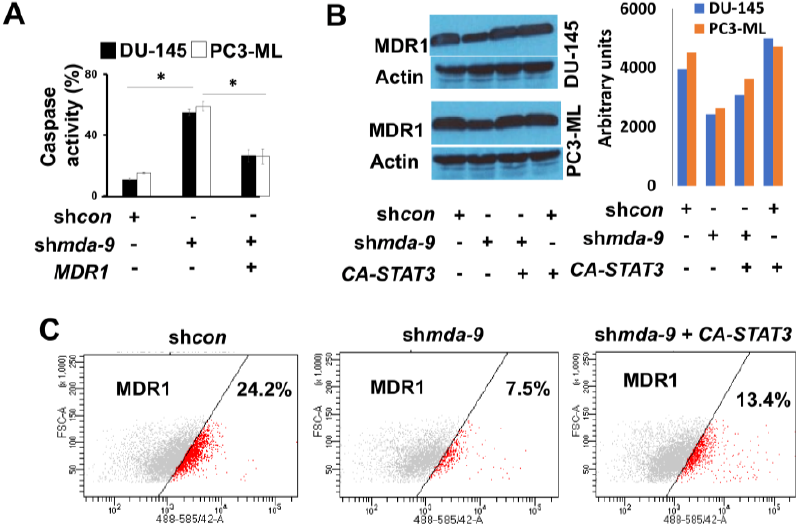
Figure 6. mda-9 regulates MDR1 expression through STAT3 activation. ( A ) E ff ect of MDR1 overexpression on mda-9 kd mediated caspase activity. ( B ) E ff ect of CA-STAT3 overexpression on MDR1 protein expression in DU-145 and PC3-ML PCSCs by Western blotting. ( C ) E ff ect of CA-STAT3 overexpression on MDR1 protein expression in ARCaP-M PCSCs by flowcytometry. The bars represent SEM. * p < 0.05, using the Student’s t -test and ANOVA.